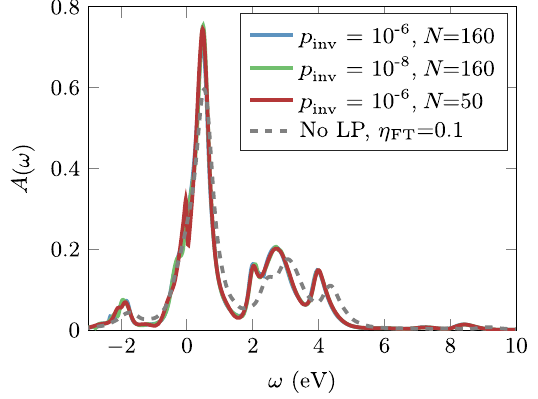
FIG. 11. Spectrum A ð ω Þ using different linear prediction parameters for a calculation without spin-flip and pair-hopping terms. The calculations with linear prediction were performed 0 . 02 eV. Except for small changes with a broadening of η FT ¼ around ω ¼ 0 , the effect of the various linear prediction param- eters is minor. The blue line lies directly below the red and green lines. We also show a DMFT calculation without any linear prediction. The main features are still